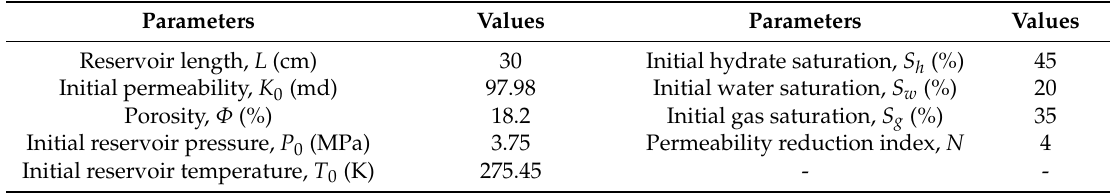
Table 1. Reservoir initial conditions in Masuda experiment [25].